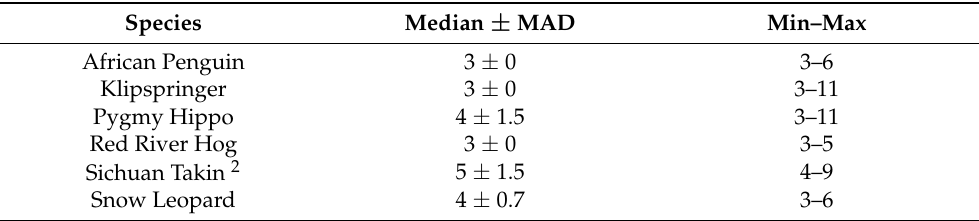
Table 2. The number of reliability test sessions required for observers to “pass 1